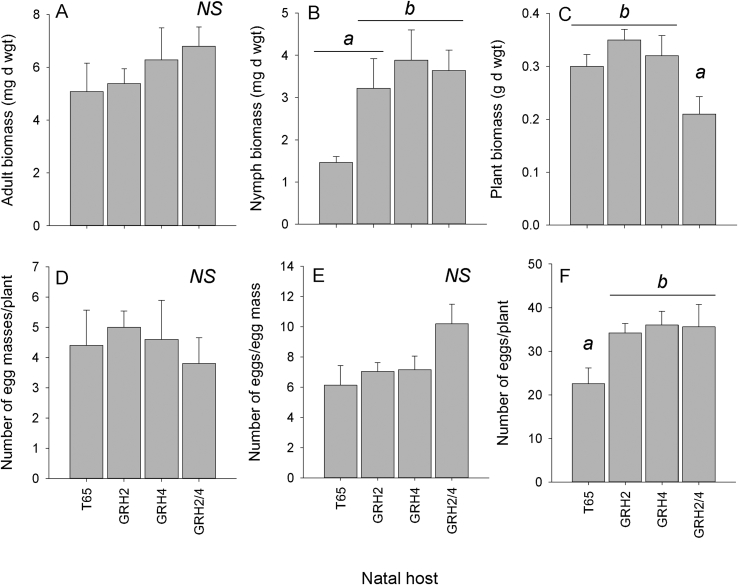
Results of fitness bioassays with colonies reared for 20 generations on T65, GRH2-NIL, GRH4-NIL or GRH2/GRH4-PYL and exposed to GRH2/GRH4-PYL. Graphs indicate (A) the biomass of adults after 15 days, (B) the biomass of nymphs after 15 days, (C) the final biomass of the host GRH2/GRH4-PYL plants after 15 days of nymph feeding, (D) the number of egg masses per plant, (E) the average size of egg masses and (F) the number of eggs per plant. Lowercase letters indicate homogenous groups (Tukey, P ≤ 0.05); standard errors are indicated (N = 5 colonies).